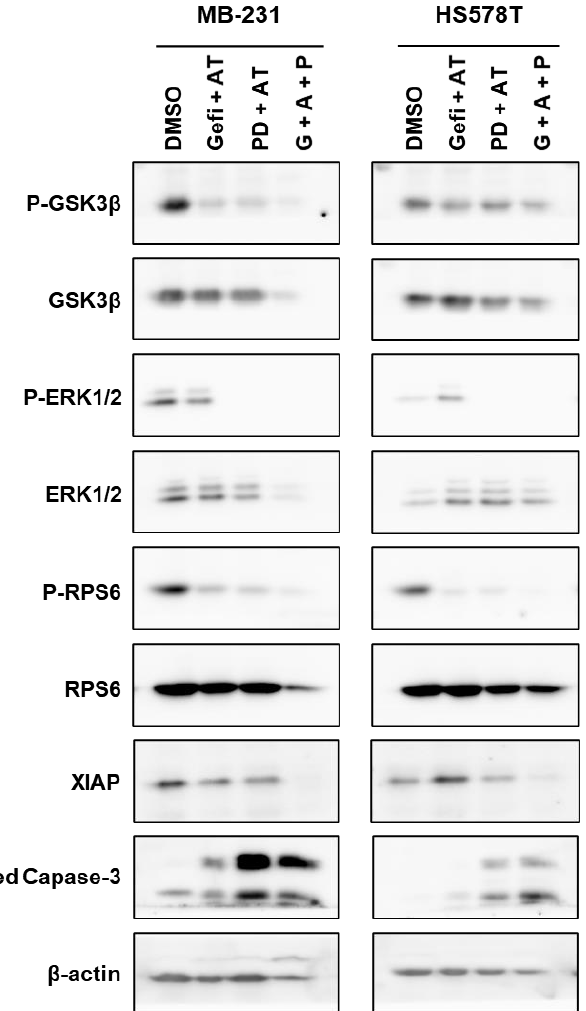
Figure 9. Western blot analysis of TNBC cells treated with different drug combinations (Figure S2). The cells were treated with drug combinations for 24 h, and the cell lysates were resolved on SDS-PAGE and proved with antibodies for indicated proteins.